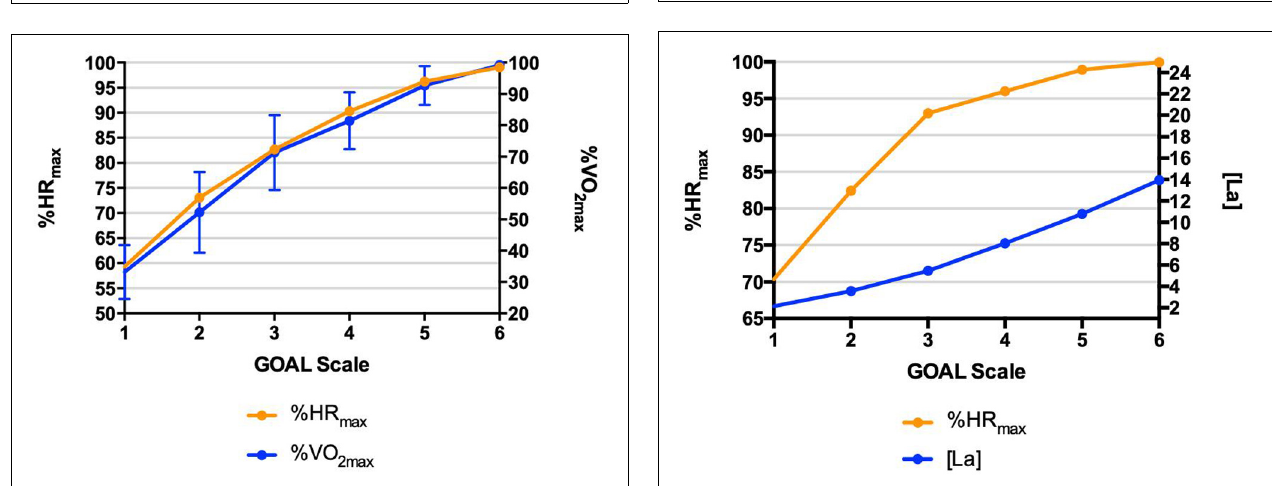
FIGURE 4 | Maximal cardiopulmonary effort test – Concurrent validation relationships among rating of perceived exertion identified by GOAL Scale and physiological parameters (heart rate percentage – %HR max and oxygen consumption percentage – %VO 2max ) during maximal incremental cardiopulmonary test; • r 2 = 0.83; • r 2 = 0.83.